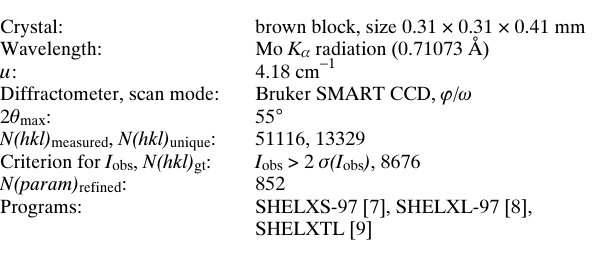
Table 1. Data collection and